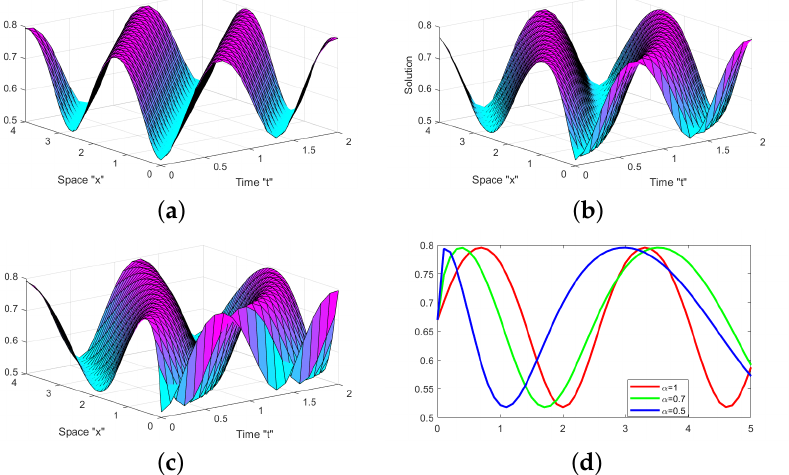
Figure 4. For Equation (25), ( a – c ) indicate the 3D profiles with σ = 0, ( d ) denotes the 2D plot for different values of α at t = 1, and the curves of the solution move to the left. ( a ) α = 1, β = 0, ( b ) α = 0.7, β = 0.9, and ( c ) α = 0.5, β = 0.9.